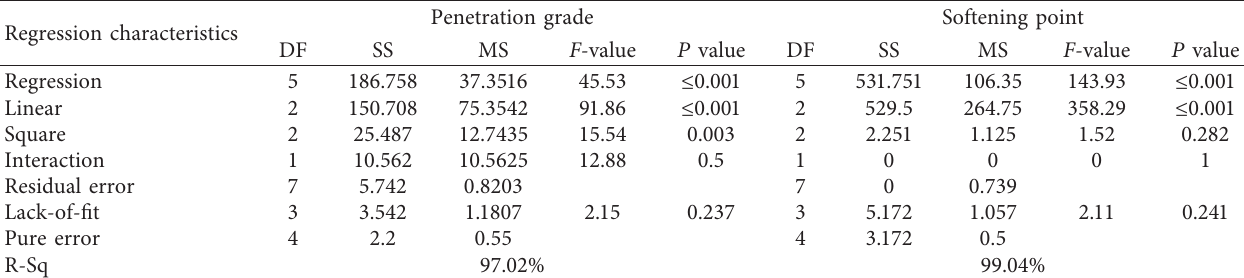
Figure 1: Contour plot of penetration grade and softening point. (a) Contour plot of pen vs. CR and EVA. (b) Contour plot of soft vs. CR and Table 3: ANOVA table for penetration grade and softening point tests.